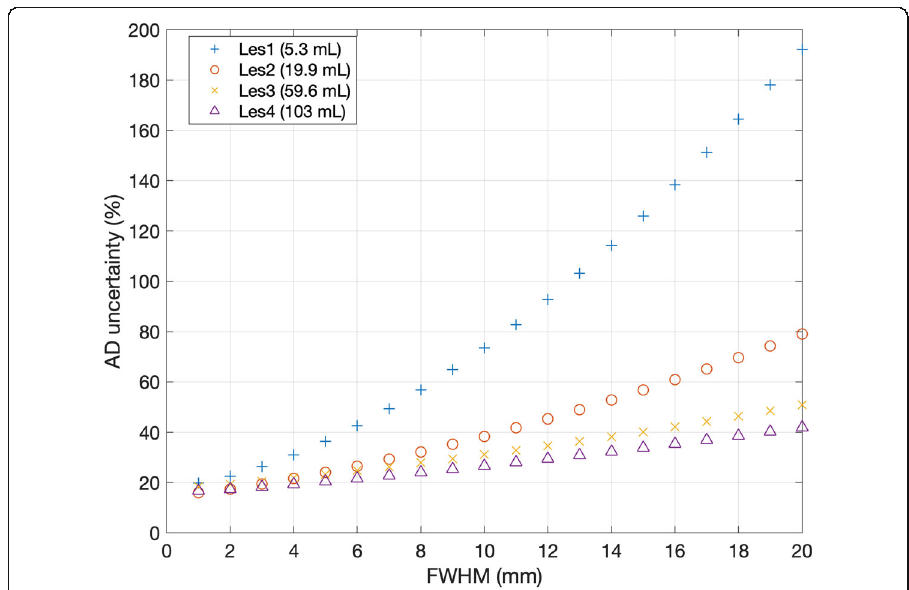
in four lesions. Lesions were chosen to fill a range of different values of volume